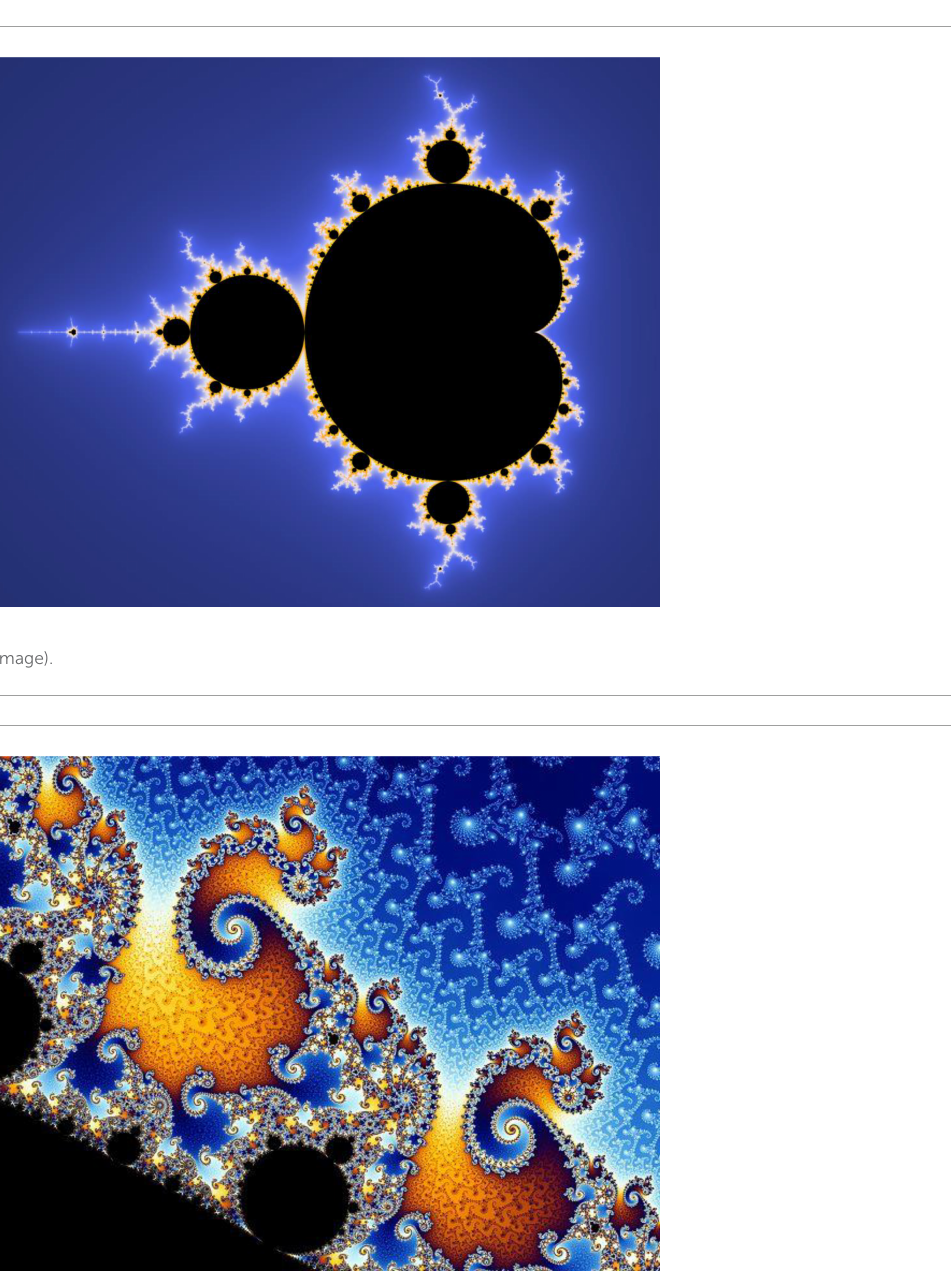
FIGURE2 Mandelbrot zoom sequence (Image credit: Wolfgang Beyer at: https://commons.wikimedia.org/w/index.php?search = the + mandelbrot + set&title = Special:MediaSearch&go = Go&type =